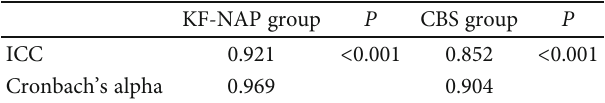
Table 2: Interrater reliability of KF-NAP and CBS.